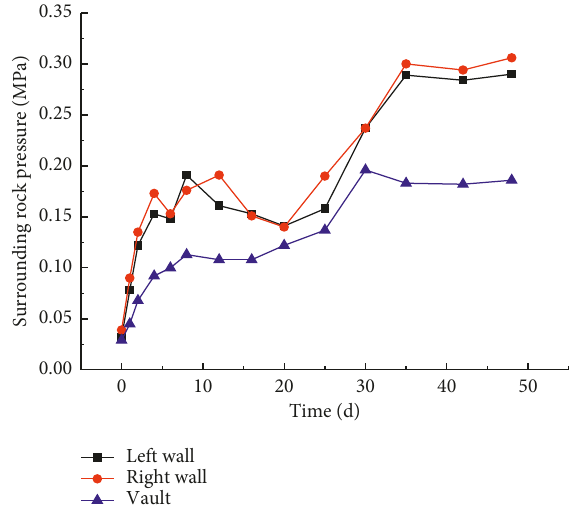
Figure 21: Surrounding rock pressure measuring